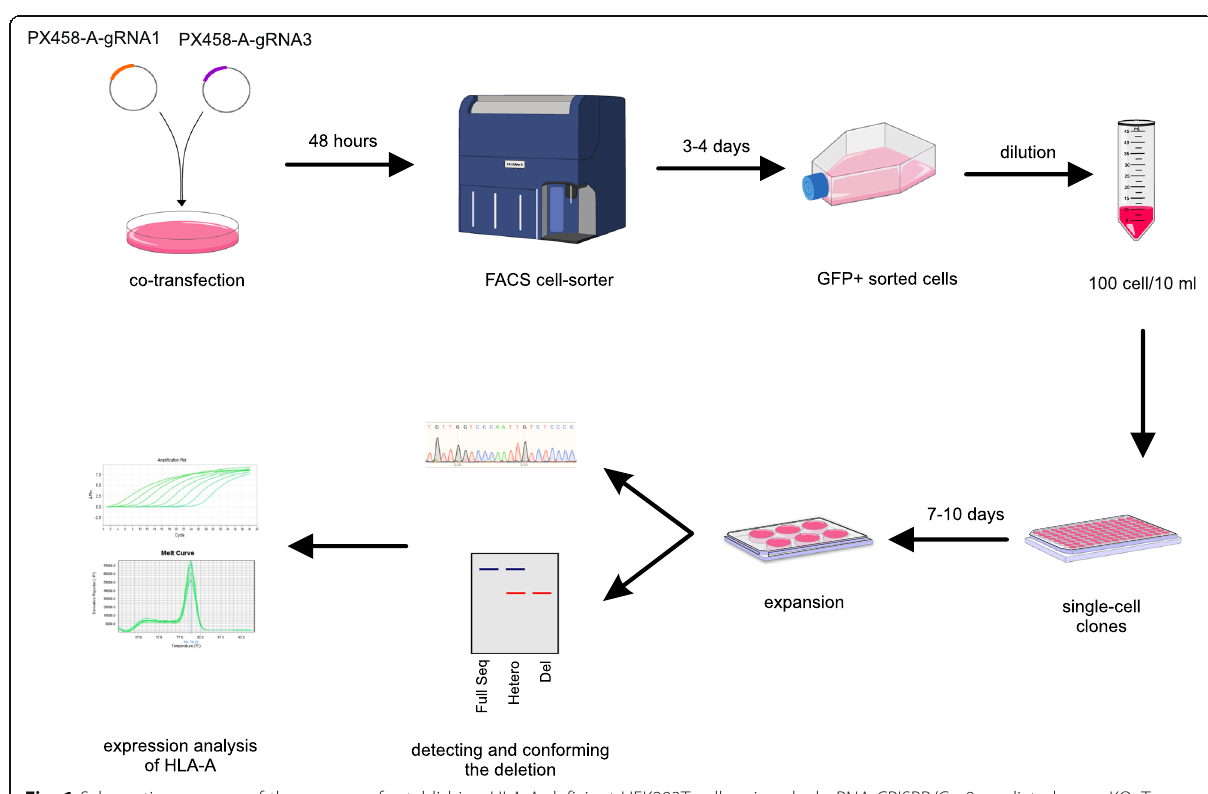
Fig. 1 Schematic summary of the process of establishing HLA-A deficient HEK293T cells using dual gRNA CRISPR/Cas9-mediated gene KO. To obtain a large deletion within the HLA-A gene, we co-transfected the cells with two plasmids containing the GFP gene and two different gRNAs. The green GFP+ cells were sorted by FACS after 48 h and then cultured to reach the confluency of 70 – 90%. After that, a suspension of cells with a defined concentration was provided to have a single cell per well in a 96-well plate. After 7 – 10 days, the DNAs of single-cell clones were extracted, and the PCR reaction and sequencing results revealed and confirmed the clones with mutations, respectively. Finally, the expression level of mutated clones was analyzed using real-time